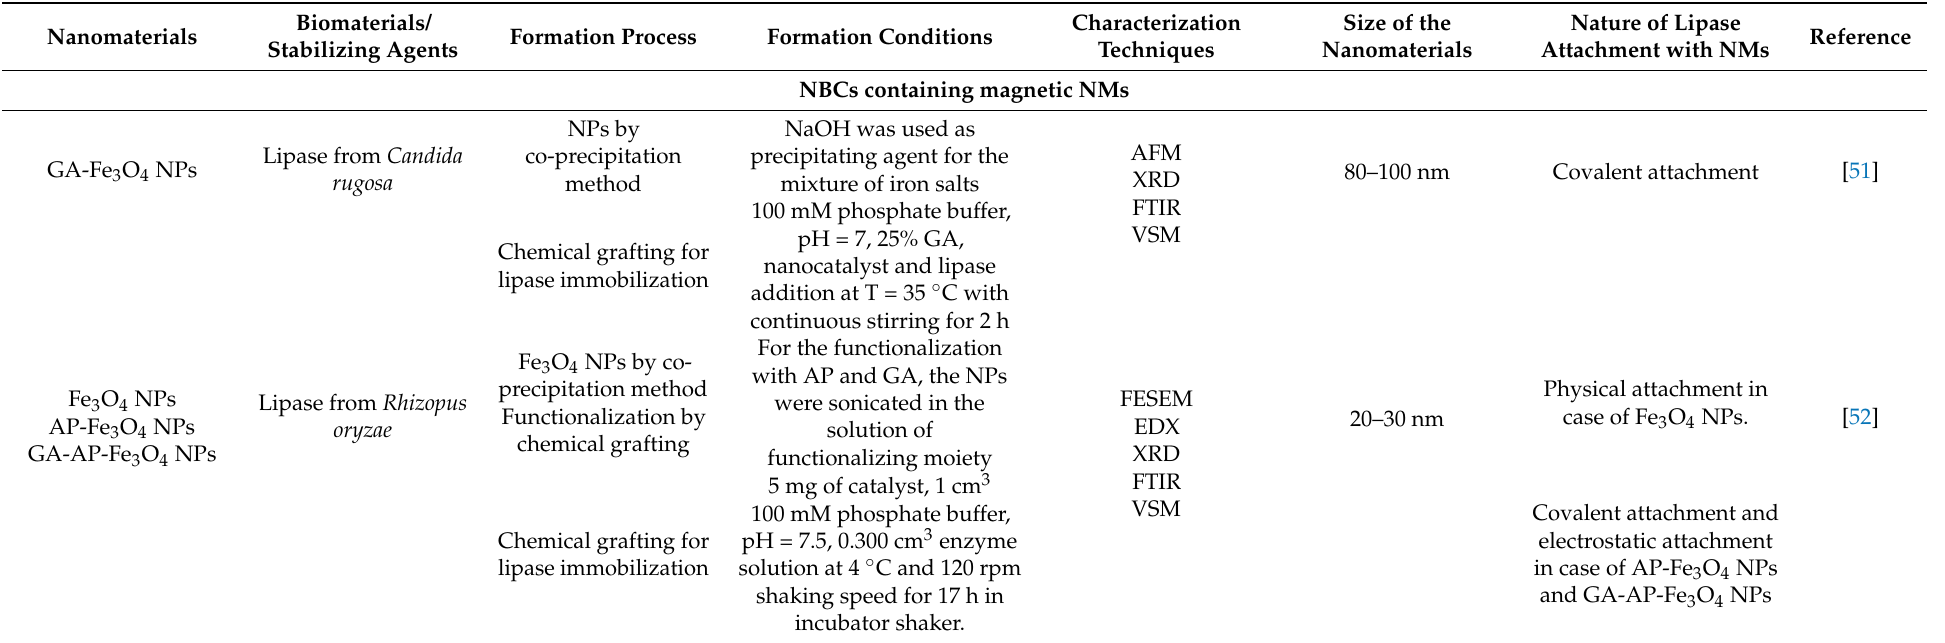
Table 2. Case studies representing the summary of the Nanobiocatalysts